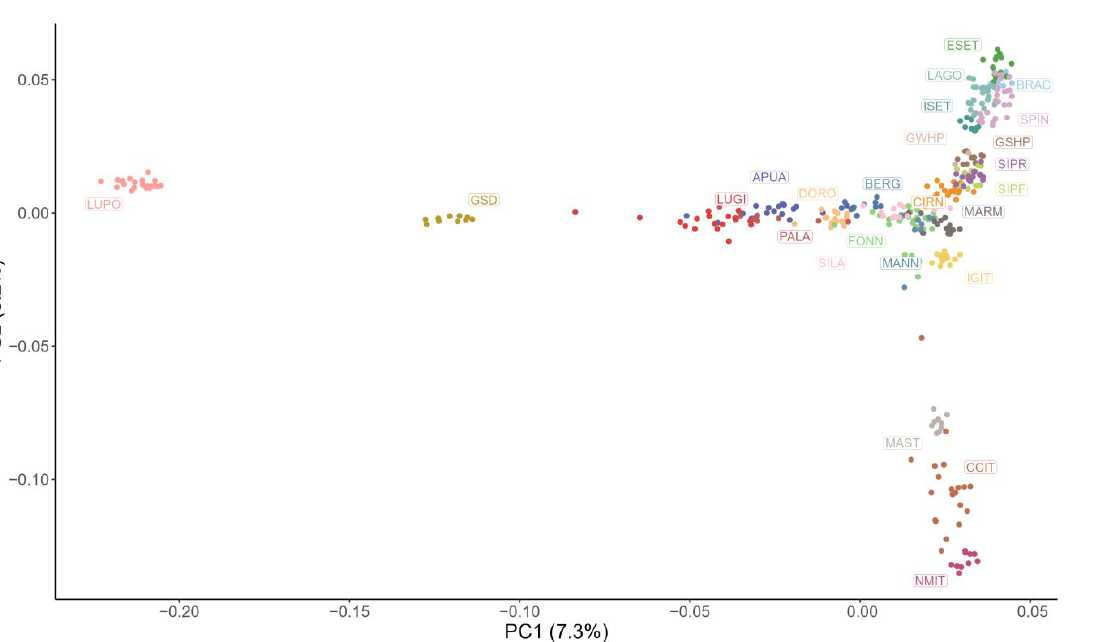
Figure 2. Multidimensional scaling analysis plot showing the first two principal components (PC). Each point represents a subject and each colour a breed: Fonni’s dog (FONN), Pastore Apuano (APUA), Bergamasco Shepherd (BERG), Bracco Italiano (BRAC), Cane Corso Italiano (CCIT), Cirneco dell’Etna (CIRN), Pastore D’Oropa (DORO), English Setter (ESET), German Shepherd dog (GSD), German Shorthaired Pointer (GSHP), German Wirehaired Pointer (GWHP), Italian Greyhound (IGIT), Irish Setter (ISET), Lagotto Romagnolo (LAGO), Lupino del Gigante (LUGI), Lupo Italiano (LUPO), Mannara dog (MANN), Maremma and the Abruzzi Sheepdog (MARM), Mastiffs (MAST), Neapolitan Mastiff (NMIT), Pastore della Lessinia e del Lagorai (PALA), Pastore della Sila (SILA), Segugio Italiano a Pelo Forte (SIPF), Segugio Italiano a Pelo Raso (SIPR), and Spinone Italiano (SPIN).